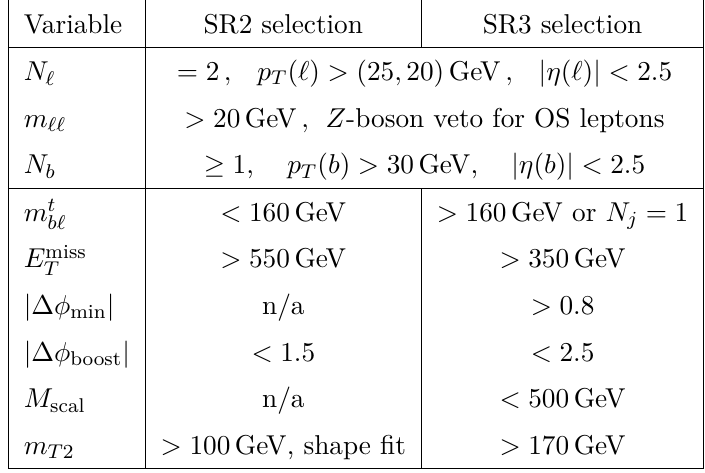
Table 2 . As table 1 but for the signal regions SR2 and SR3. More details can be found in the main